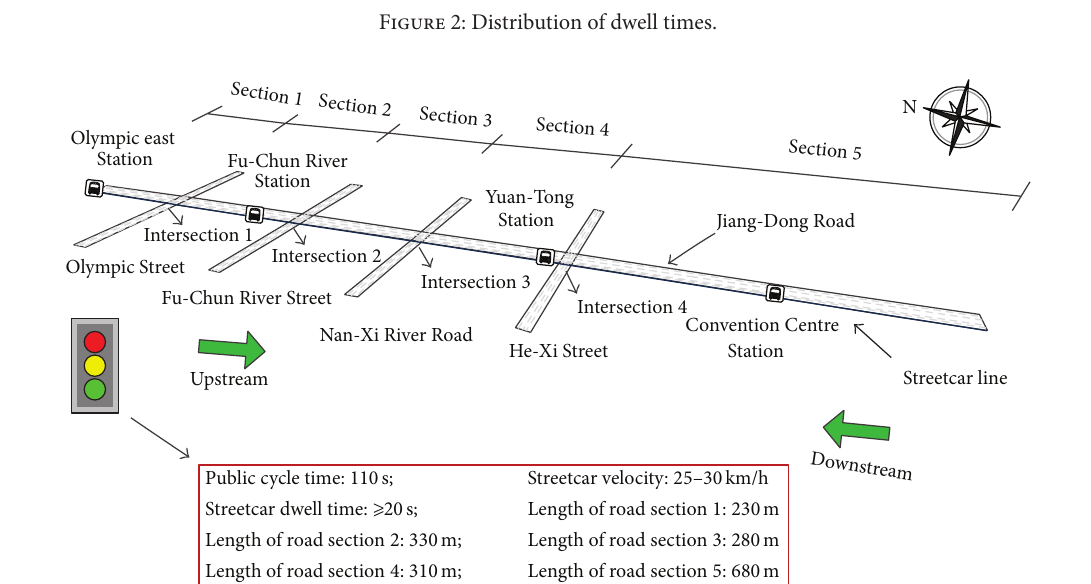
Figure 2: Distribution of dwell times.